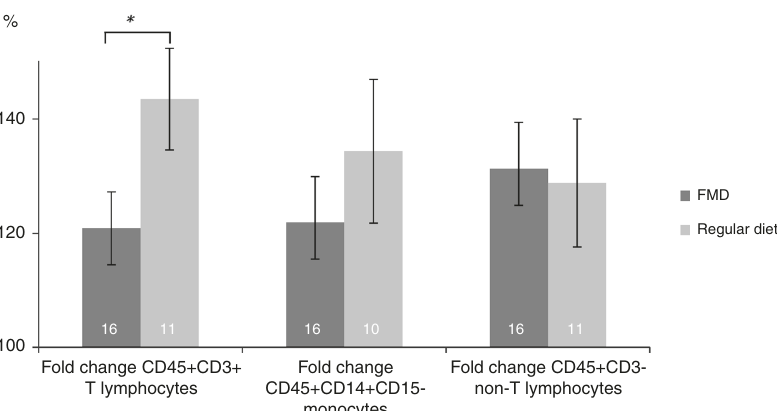
Fig. 6 Difference of γ -H2AX intensity in CD45 + CD3 + lymphocytes of each patient before cycle 1 and 3 h after chemotherapy, given as a percentage increase. Error bars indicate the standard error of the mean. Independent t -tests were used (2-sided). Abbreviations: FMD: fasting mimicking diet. * P = 0.045. Source data are provided as a Source Data fi